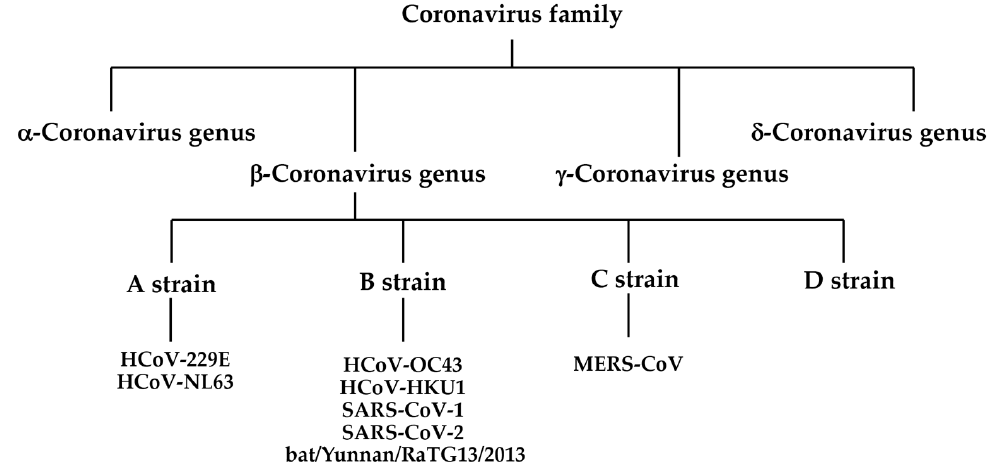
Figure 1. Classification of coronavirus family.